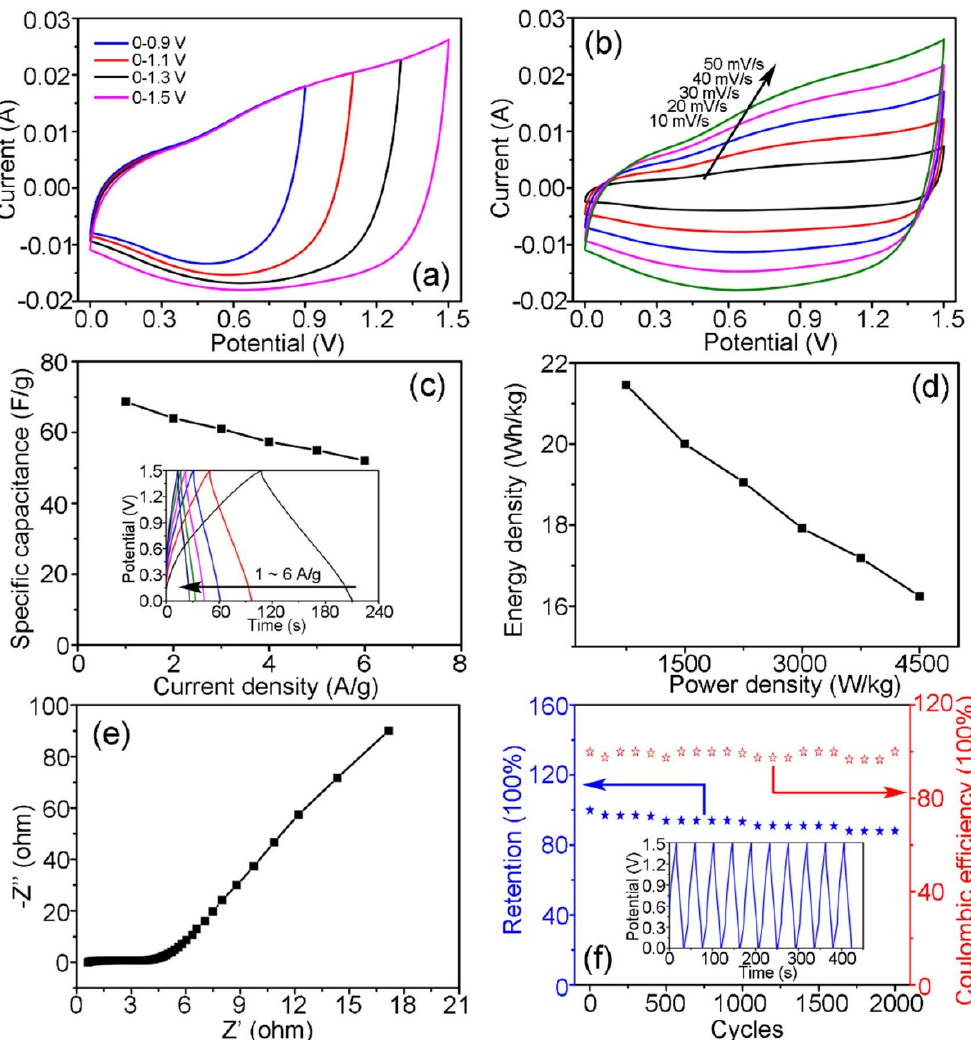
Figure 5. NiCo 2 O 4 //AC-ASC characteristic chart. ( a ) CV curves of NiCo 2 O 4 //AC-ASC at different scan voltage windows, ( b ) CV curves, ( c ) The specific capacitances (based on the total mass of active materials), ( d ) Ragone plots, ( e ) Nyquist plots, ( f ) Cycle performance and Coulombic efficiency of NiCo 2 O 4 //AC-ASC device. Inset in ( c , f ) is CD curves of NiCo 2 O 4 //AC-ASC at different current densities and the first 10th CD curves of NiCo 2 O 4 //AC-ASC device, respectively. Reprinted with permission from Ref. [86]. Copyright 2017, Elsevier Inc.